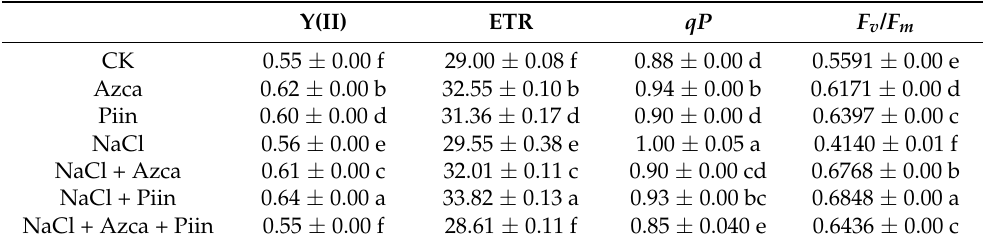
Table 2. Chlorophyll fluorescence parameters of tomato leaves under different treatments.